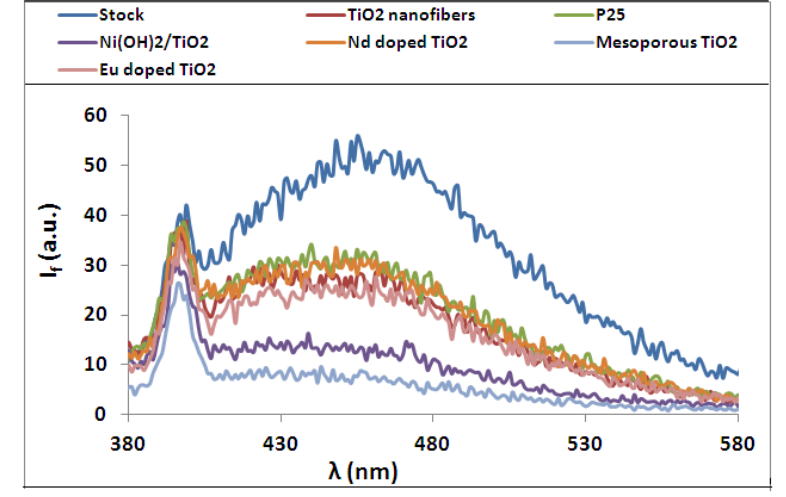
Figure 1. Dark adsorption of fulvic acids (FAs) (3 times diluted samples) on the surface of the selected photocatalysts (2.5 g/L) at pH = 6.7, indicated by reduction in fluorescence intensity. Fluorescence spectra were recorded for λ = 350 nm (3 times diluted samples). excitation